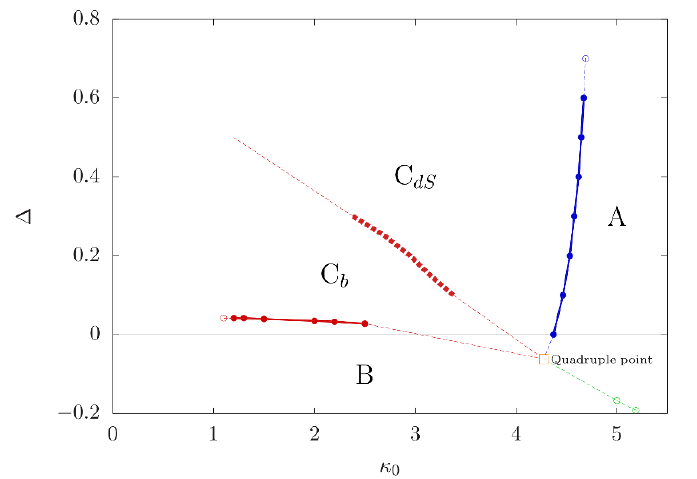
Figure 3 . Phase diagram of CDT with spherical spatial